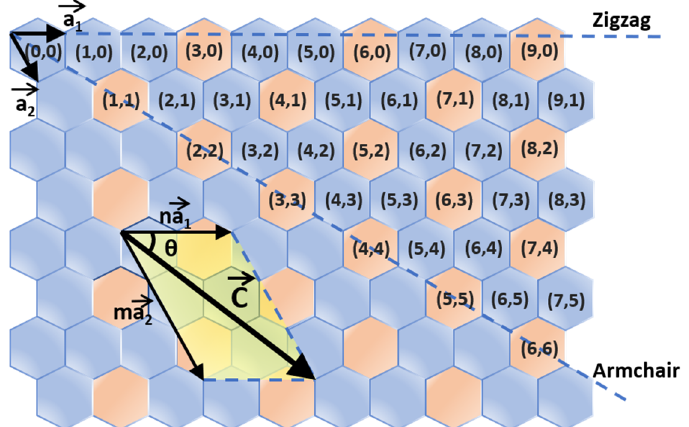
Figure 1. Chirality map showing the structure of single ‐ walled carbon nanotubes (SWNTs). The chirality indices of semiconducting SWNTs (s ‐ SWNTs) are labeled with blue, others are metallic SWNTs (m ‐ SWNTs) (orange). Approximately 2/3 of as ‐ produced SWNTs are semiconducting.